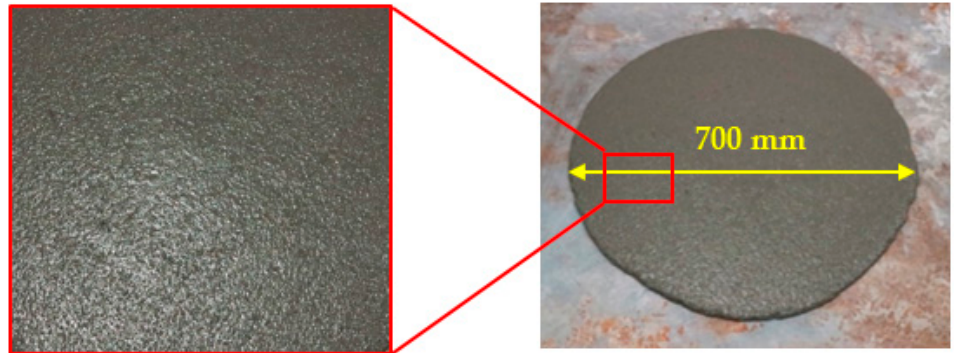
Figure 12. Flow diameter of UHPC.